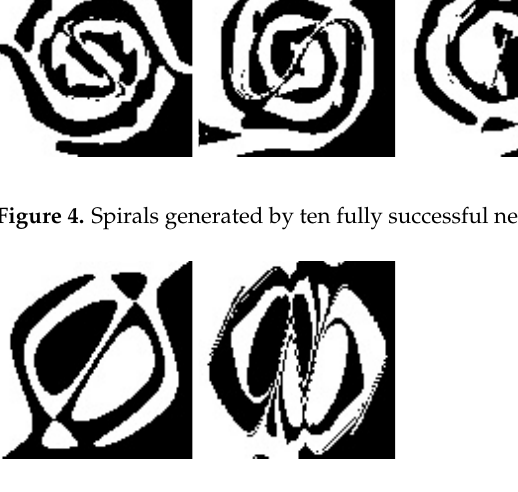
Figure 5. Example spirals generated by NEAT